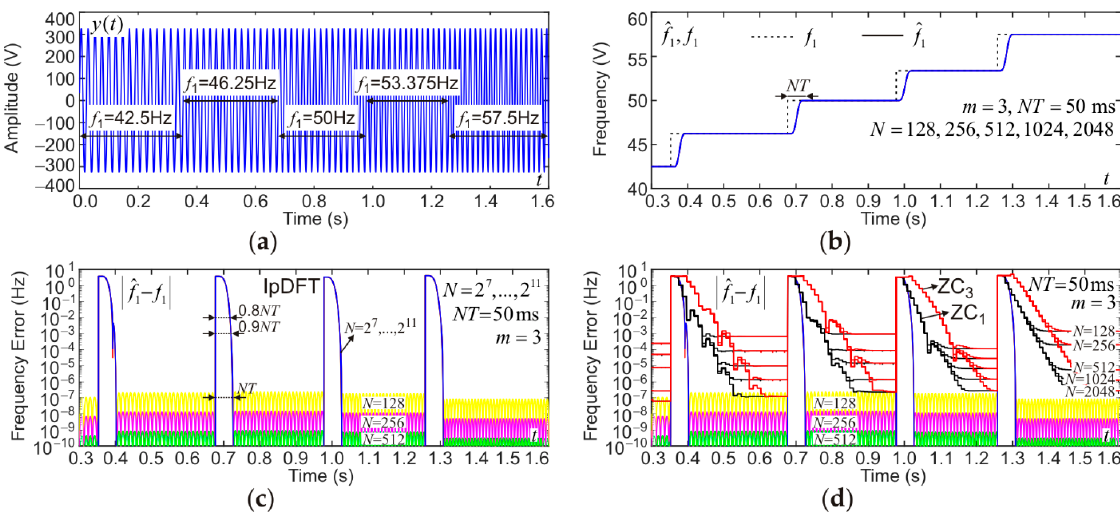
Figure 18. Effect of frequency stepping on the estimation results: ( a ) frequency change from 42.5 Hz to 57.5 Hz every 15 periods; ( b , c ) estimation result of IpDFT method for m = 3 at 50 ms measurement time and for N = 128, 256, 512, 1024 and 2048; ( d ) comparison of accuracy of IpDFT method for m = 3 and NT = 50 ms with ZC method for N = 128, 256, 512, 1024 and 2048.